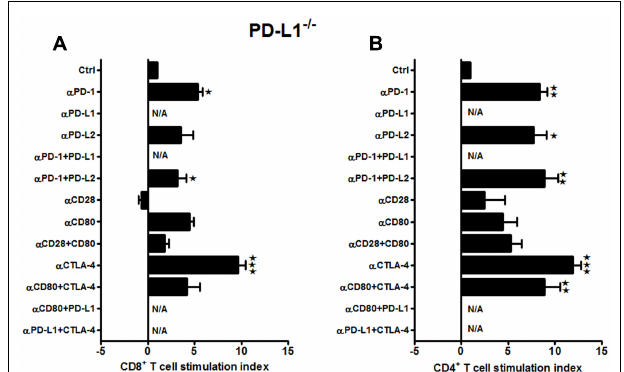
FIGURE 4 | Subtle changes in the proliferative capacities in the PD-L2 − / − mice indicate a minor role of PD-L2 in ischemic stroke. T-cells were purified, by negative sort, from the spleens of MCAO-subjected PD-L2 − / − mice, by labeling with specific microbeads and separating on the AutoMACS TM .The purifiedT-cells were CSFE-labeled and then cultured with non-T-cells from the same mice at a 1:1 ratio (T:APC) in the presence of anti-CD3 antibody (2.5 μ g/mL; baseline) and other neutralizing Abs (10 μ g/mL) to co-stimulatory molecules, in 96-well plates. After 72 h of culture, cells were washed and evaluated by FACS Calibur for (A ) CD8 + and (B) CD4 + T-cell expression and CFSE dilution. Data represent the stimulation indices of the CD8 and CD4T-cells in the presence of neutralizing Abs as compared to the control (T:APC + anti-CD3 Ab) condition).The data are represented such that the baseline value is 1 and all other values are adjusted relative to the baseline. Data presented are representative of splenocytes obtained from seven PD-L2 − / − mice, with at least three separate experiments and each experiment comprising duplicates or triplicates of the given neutralizing Ab condition. Significant differences between sample means are indicated as * p ≤ 0.05, ** p ≤ 0.01 as compared to the baseline